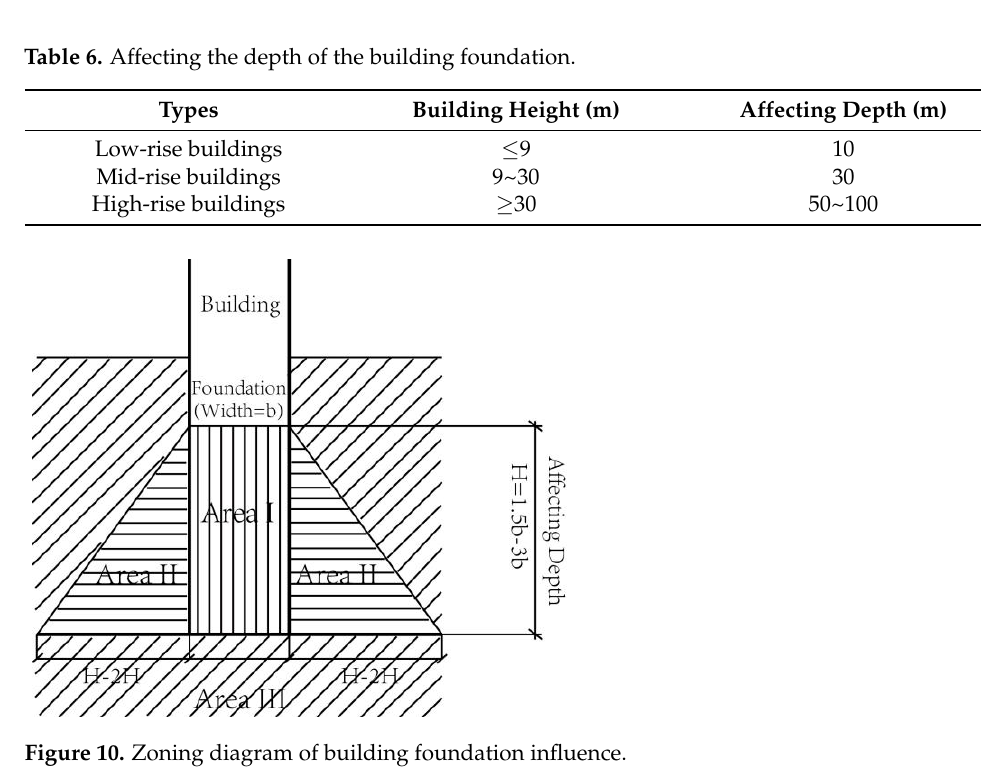
Table 6. Affecting the depth of the building foundation.